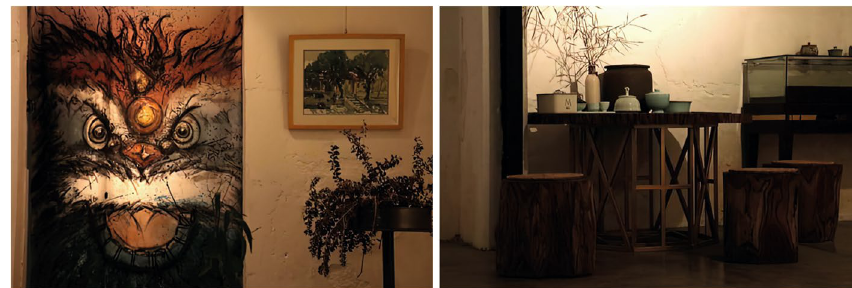
Fig. 2 Paintings and Porcelain Inside Wangchuan Cafe, 2021 (Source: the